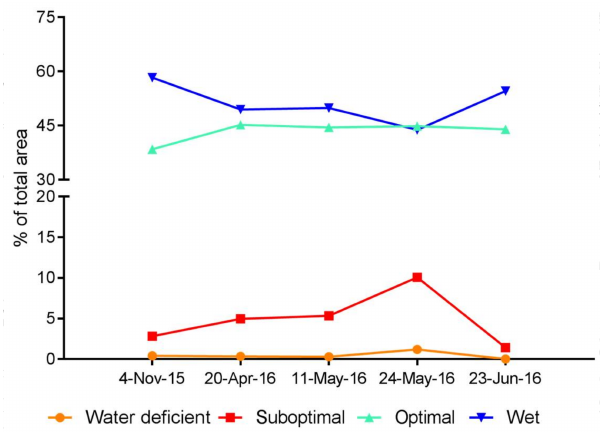
Figure 11. Percentage of total area for CO 2 uptake efficiency for hollows for five dates at the Mer Bleue